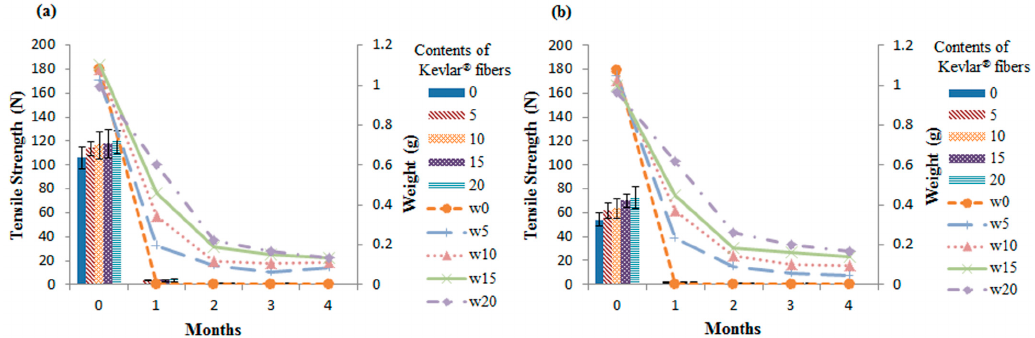
Figure 5. Tensile strength and weight along the (a) CD and (b) MD of recycled Kevlar ® /PET/LPET nonwoven geotextiles that are immersed in NaOH at 23 °C for 4 months.